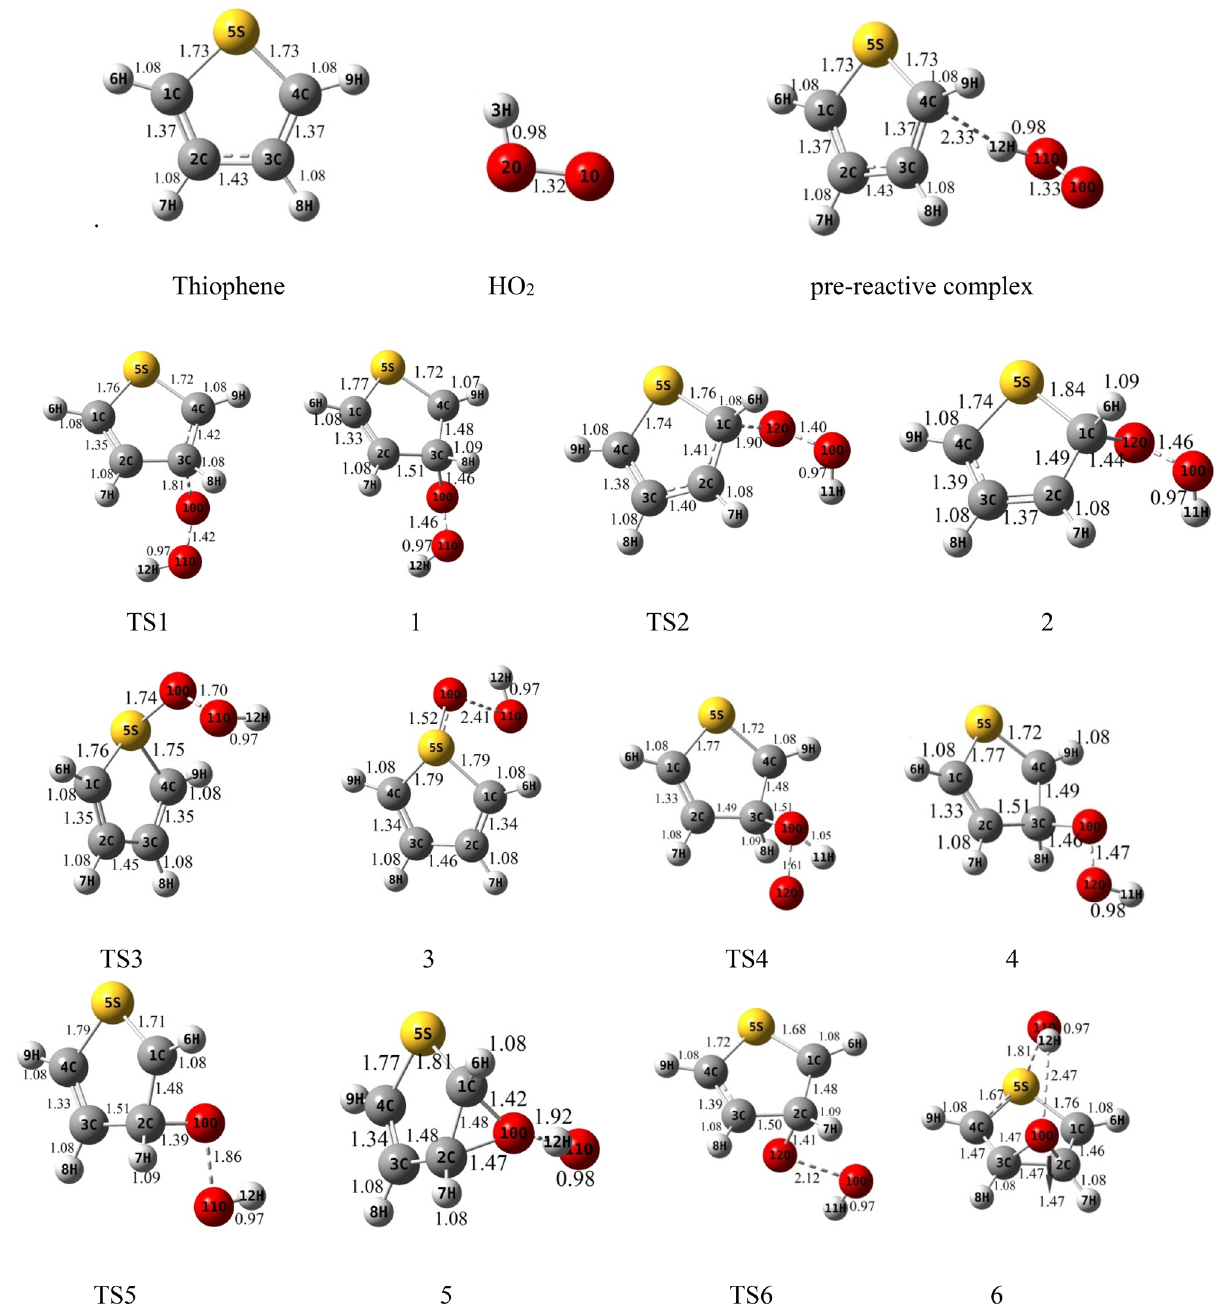
Figure 2. Geometries of reactants, transition states, intermediates, and products optimized at the B3lyp/6- 311 + g(d,p) level (bond distances are in